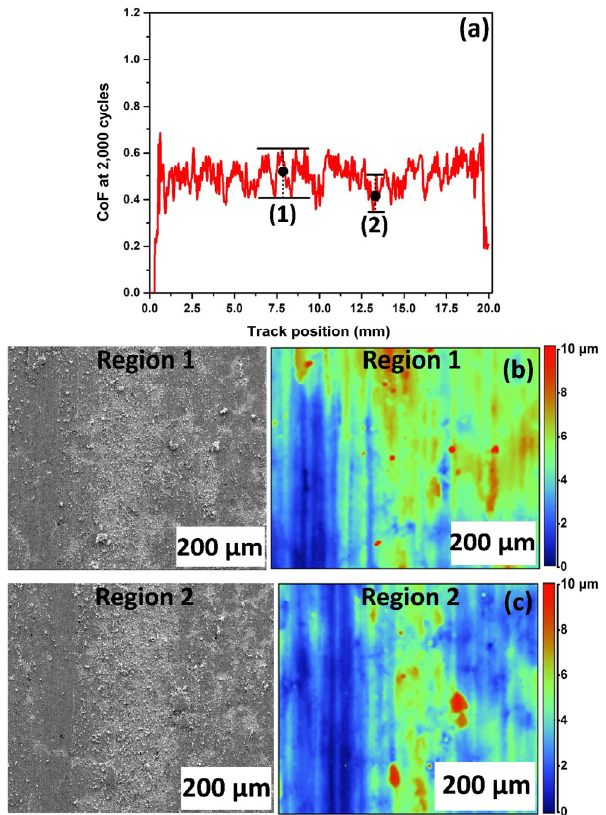
Fig. 17 (a) CoF with track position at end of test (2,000 cycles) showing (b) and (c) wear debris scattered on the surface with steel and Cd.